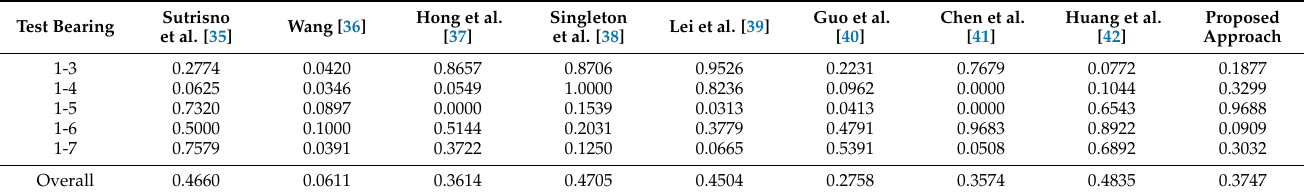
Table 10. Comparison of performance scores of the proposed approach with the previous